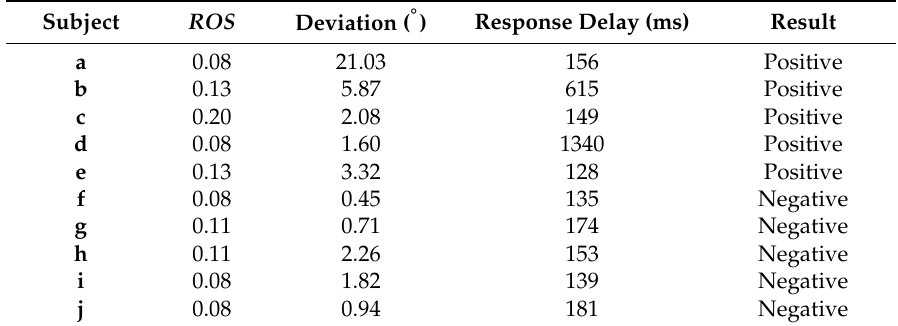
Table 2. Values Obtained in the Three Parameters under Analysis (Highlighting the Abnormal) as well as the Evaluation